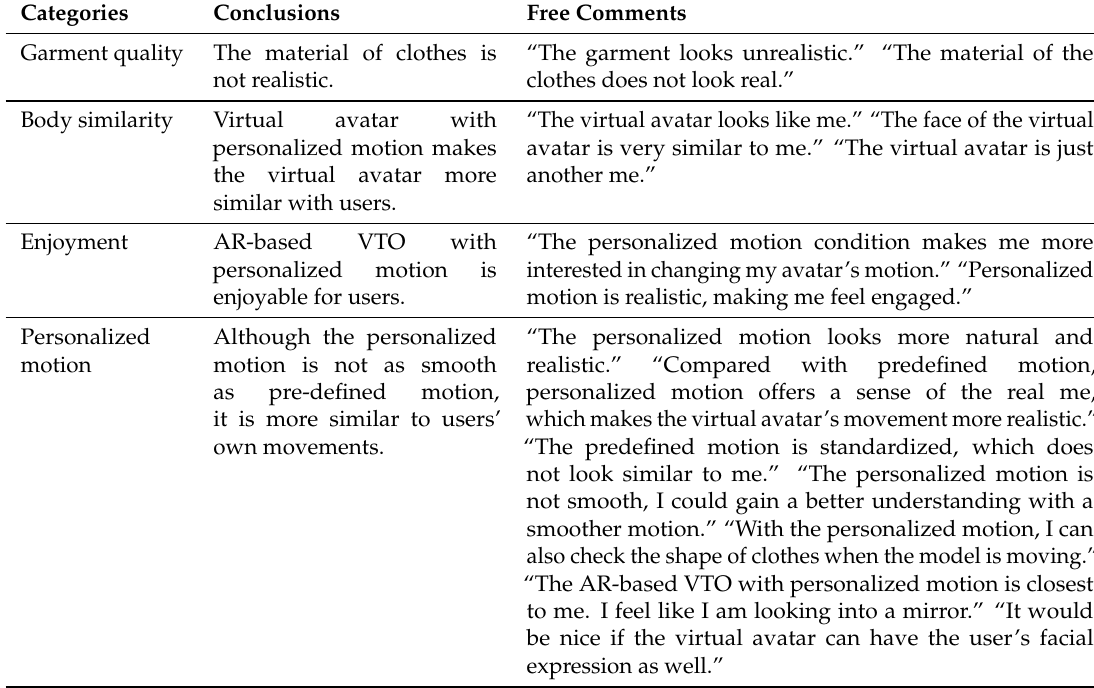
Table 7. Illustrative excerpts and main conclusions in free